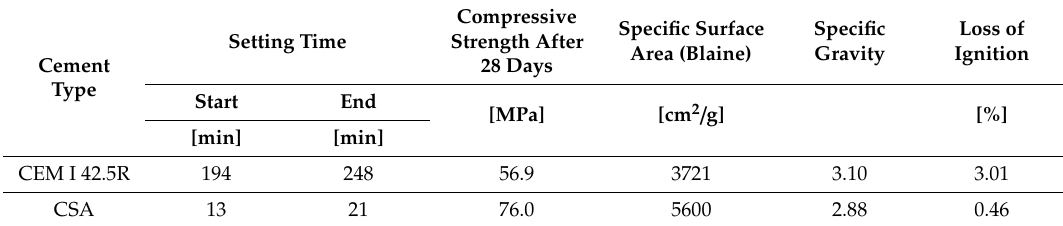
Table 2. Basic physical properties of the